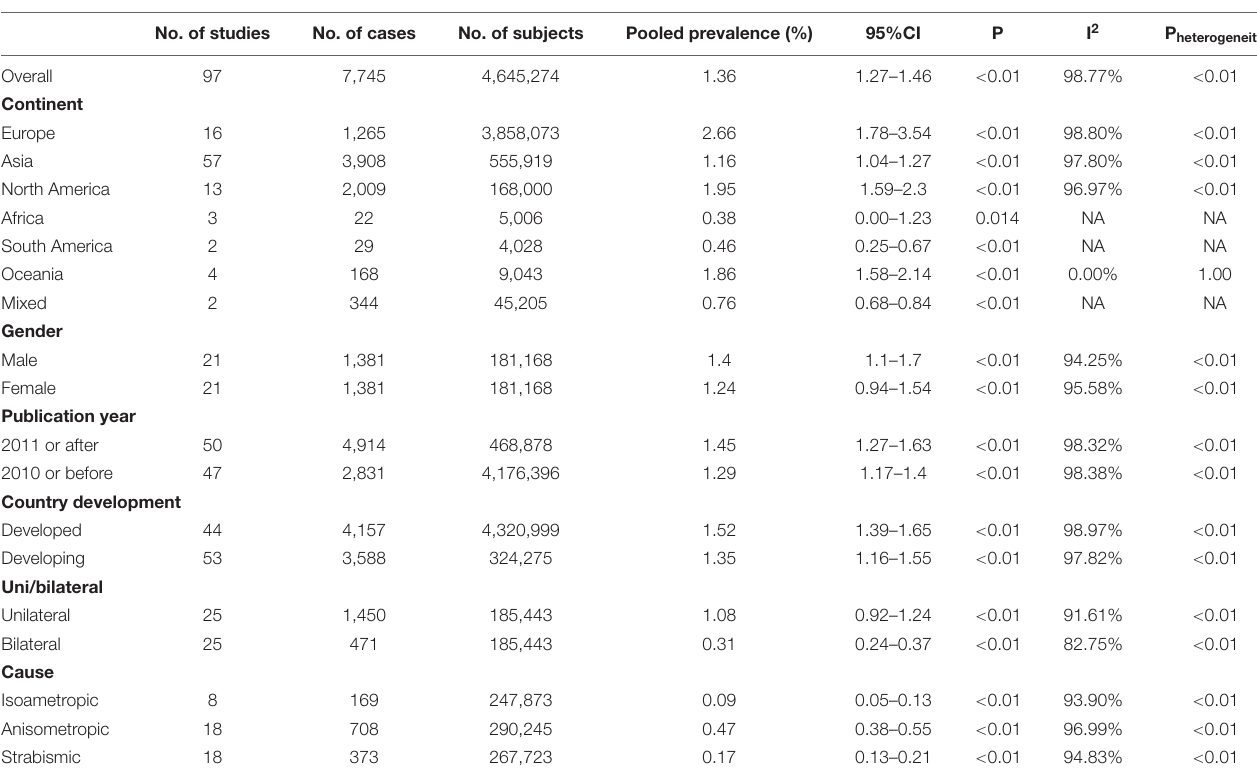
TABLE 1 | Subgroup results.